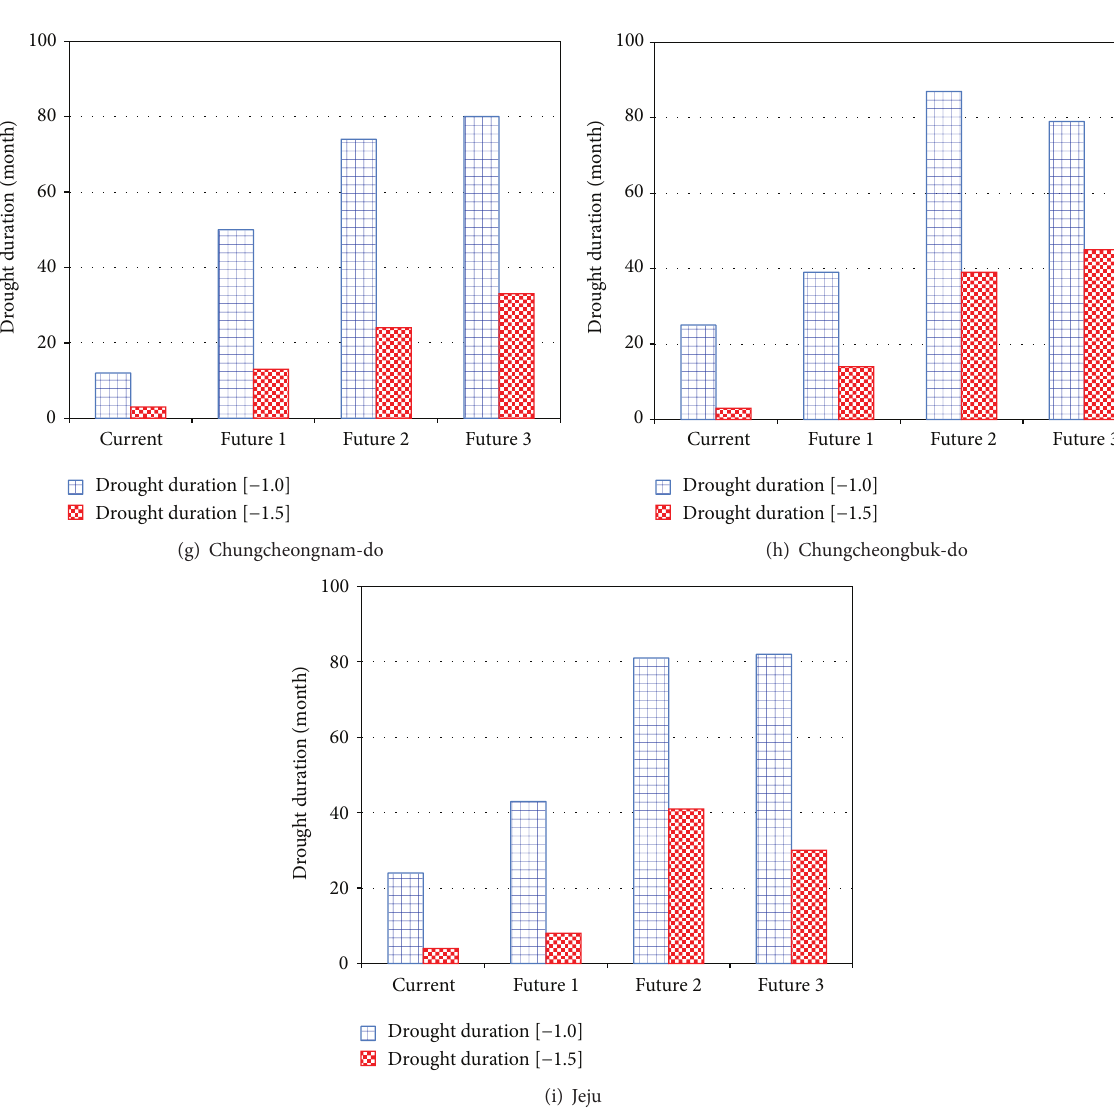
Figure 13: Change in drought duration in the current and future